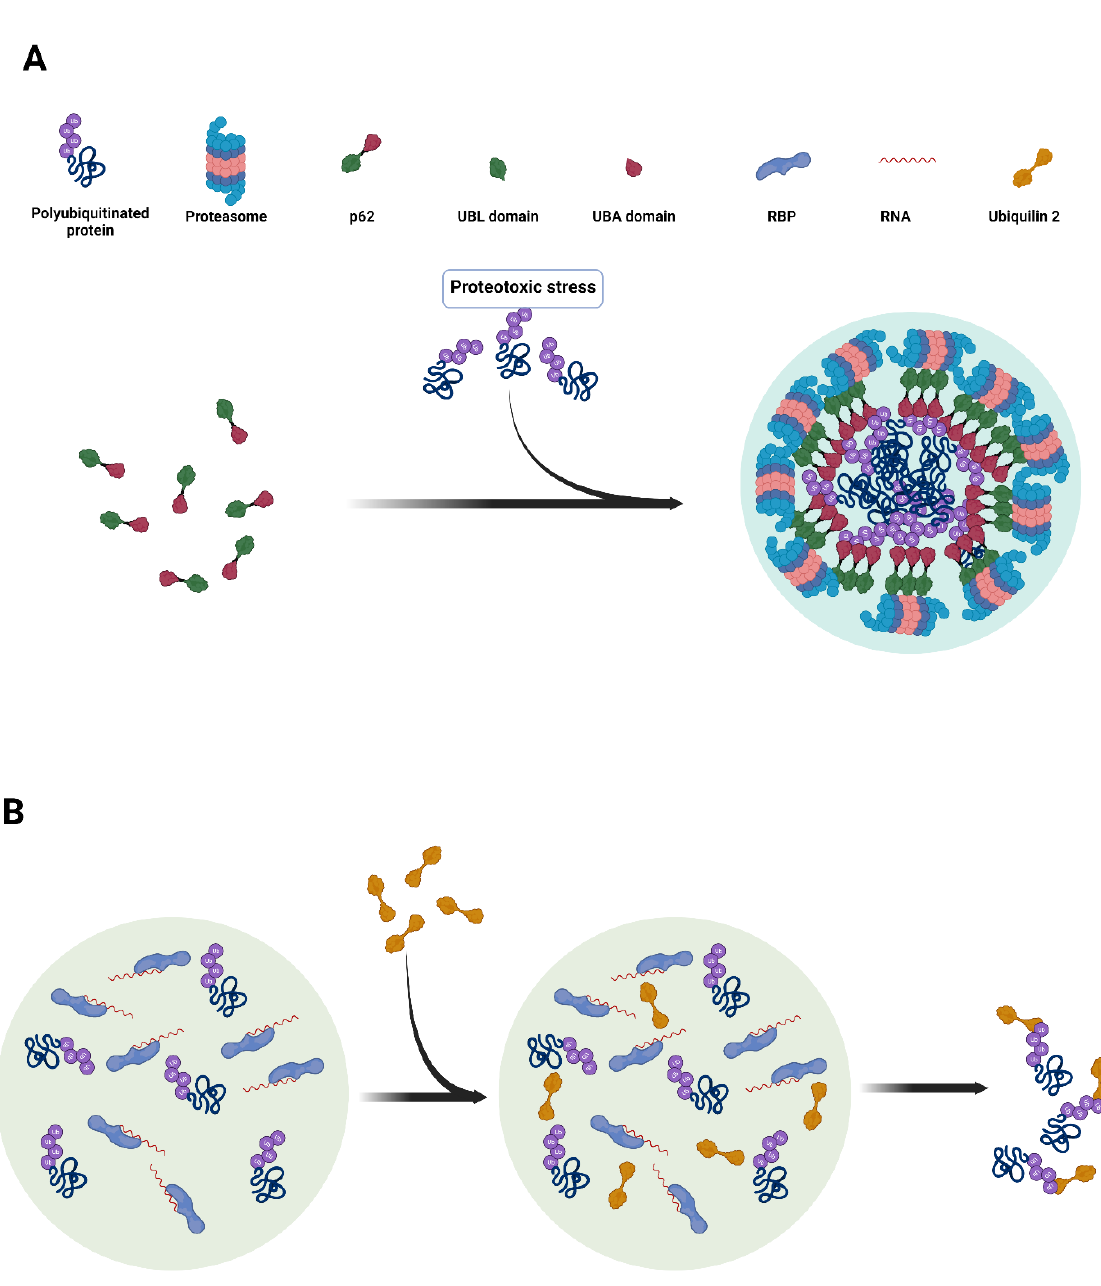
Figure 1. ( A ) Formation of nuclear p62 UPS condensates. Proteotoxic stress causes an increase in the number of ubiquitinated substrates, which require degradation. Polyubiquitin chains function as multivalent molecules, which drive condensation by binding to the UBA domain of p62. Oligomer- ization of p62 further contributes to multivalency. p62 recruits proteasomes to the condensate via its UBL domain. A similar mechanism drives the formation of RAD23B condensates, with the exception that RAD23B is not known to form oligomers like p62. ( B ) Model for UBQLN2-mediated extraction of ubiquitinated proteins from cytoplasmic SGs, consistent with the one proposed by [32]. SGs assemble via multivalent interactions between RNA-binding proteins and RNA. UBQLN2 enters SGs via its intrinsic phase separation propensity for phase separation. Once in SGs, UBQLN2 binding to ubiquitin chains causes it to dissociate from SGs, carrying with it bound ubiquitin-conjugated proteins. These are then likely delivered to the proteasome for degradation.